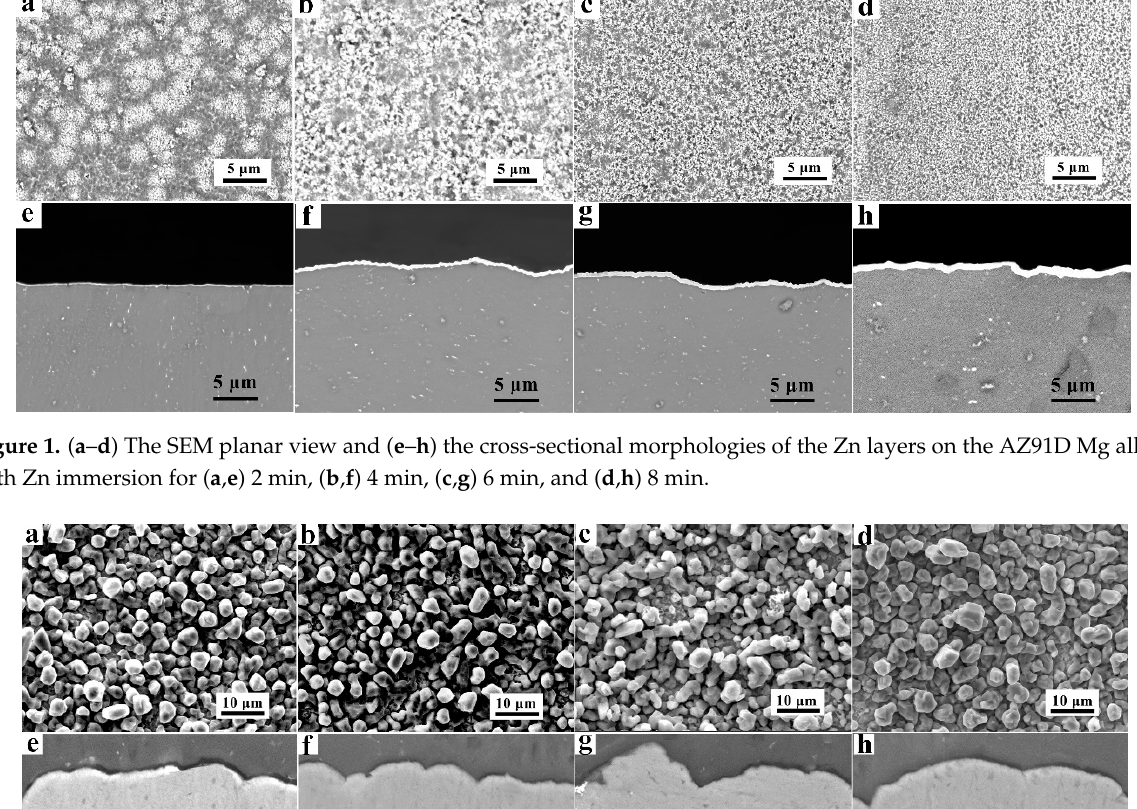
Figure 1. ( a – d ) The SEM planar view and ( e – h ) the cross-sectional morphologies of the Zn layers on the AZ91D Mg alloys with Zn immersion for ( a , e ) 2 min, ( b , f ) 4 min, ( c , g ) 6 min, and ( d , h ) 8 min.